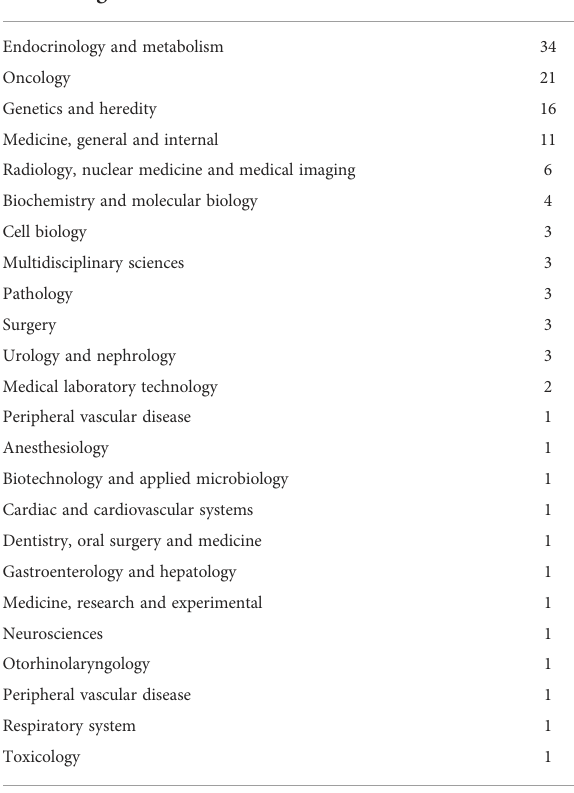
TABLE 5 WOS categories in the top 100 most-cited